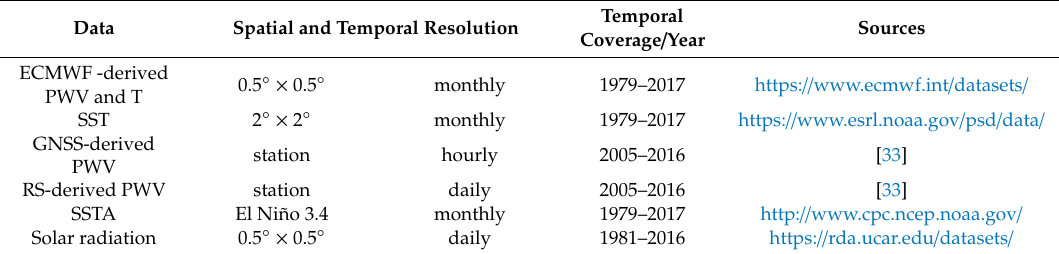
Table 1. Characteristics of the datasets selected in the